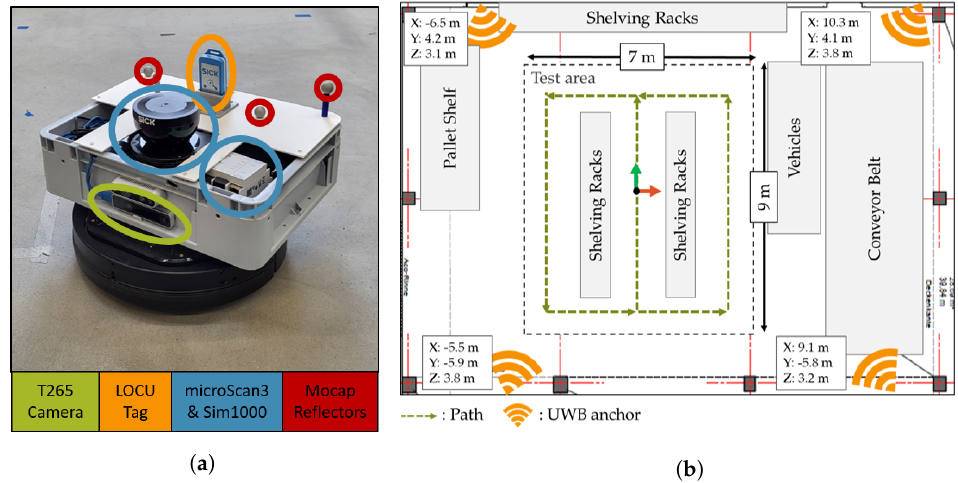
Figure 13. ( a ) Turtlebot2 carrying the localization sensors and motion capture reflectors. ( b ) Schematic overview of the Experiment Spec